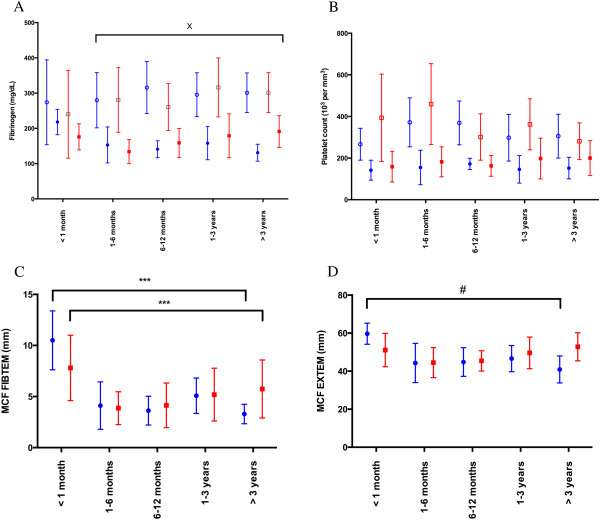
Coagulation parameters based on age and the presence of cyanotic disease. (A) Fibrinogen levels measured using the Clauss method at baseline and after cardiopulmonary bypass (CPB) (p < 0.001). (B) Platelet count at baseline and after CPB (p < 0.001). (C) Maximal clot firmness obtained on FIBTEM after CPB. (D) Maximal clot firmness obtained on EXTEM after CPB. ***p < 0.001 comparing < 1 month and all other groups with cyanotic and non-cyanotic diseases, #p < 0.01 comparing < 1 month and all other groups with cyanotic diseases. Blue, cyanotic patients; red, non-cyanotic patients; clear symbols represent baseline tests; and full symbols represent post-CPB tests.